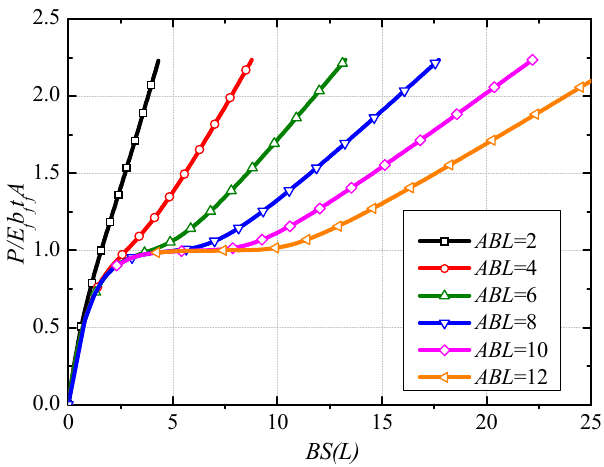
Figure 2. Normalized Load-slip response under different bond length.